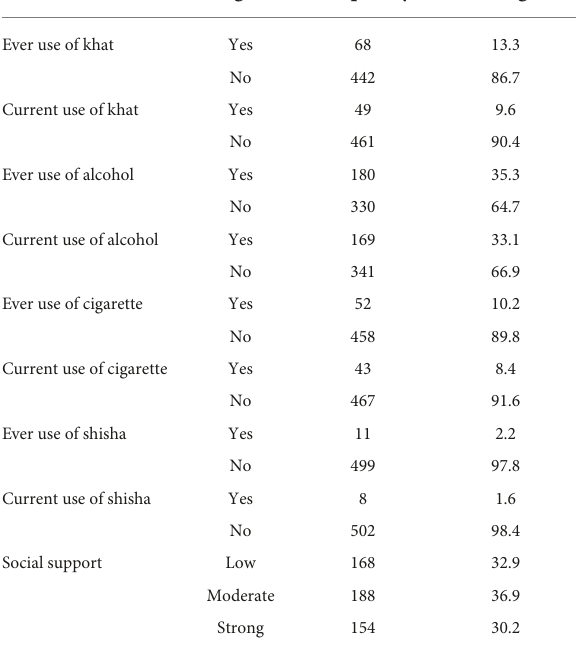
TABLE 3 Description of substance use and psychosocial characteristics of nurses working at comprehensive specialized hospitals in Northwest Ethiopia, 2021 ( n =